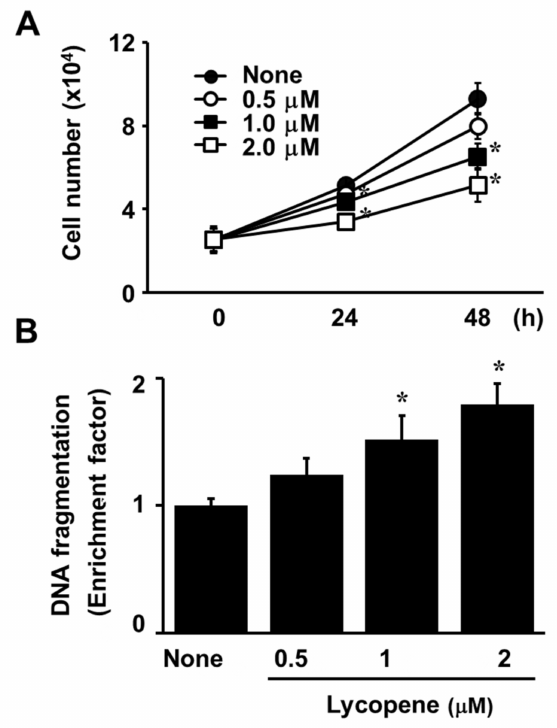
Figure 1. Lycopene inhibits cell proliferation and increases DNA fragmentation. ( A ) The cells were treated with the indicated concentrations of lycopene for 24 and 48 h. Cell viability was assessed using the trypan blue exclusion test. ( B ) The cells were treated with the indicated concentrations of lycopene for 24 h. DNA fragmentation was assessed by the amount of nucleosome-bound DNA in the cell lysates. The level of DNA fragmentation for untreated cells was set as 1. * p < 0.05 versus the cells treated with a vehicle tetrahydrofuran without lycopene